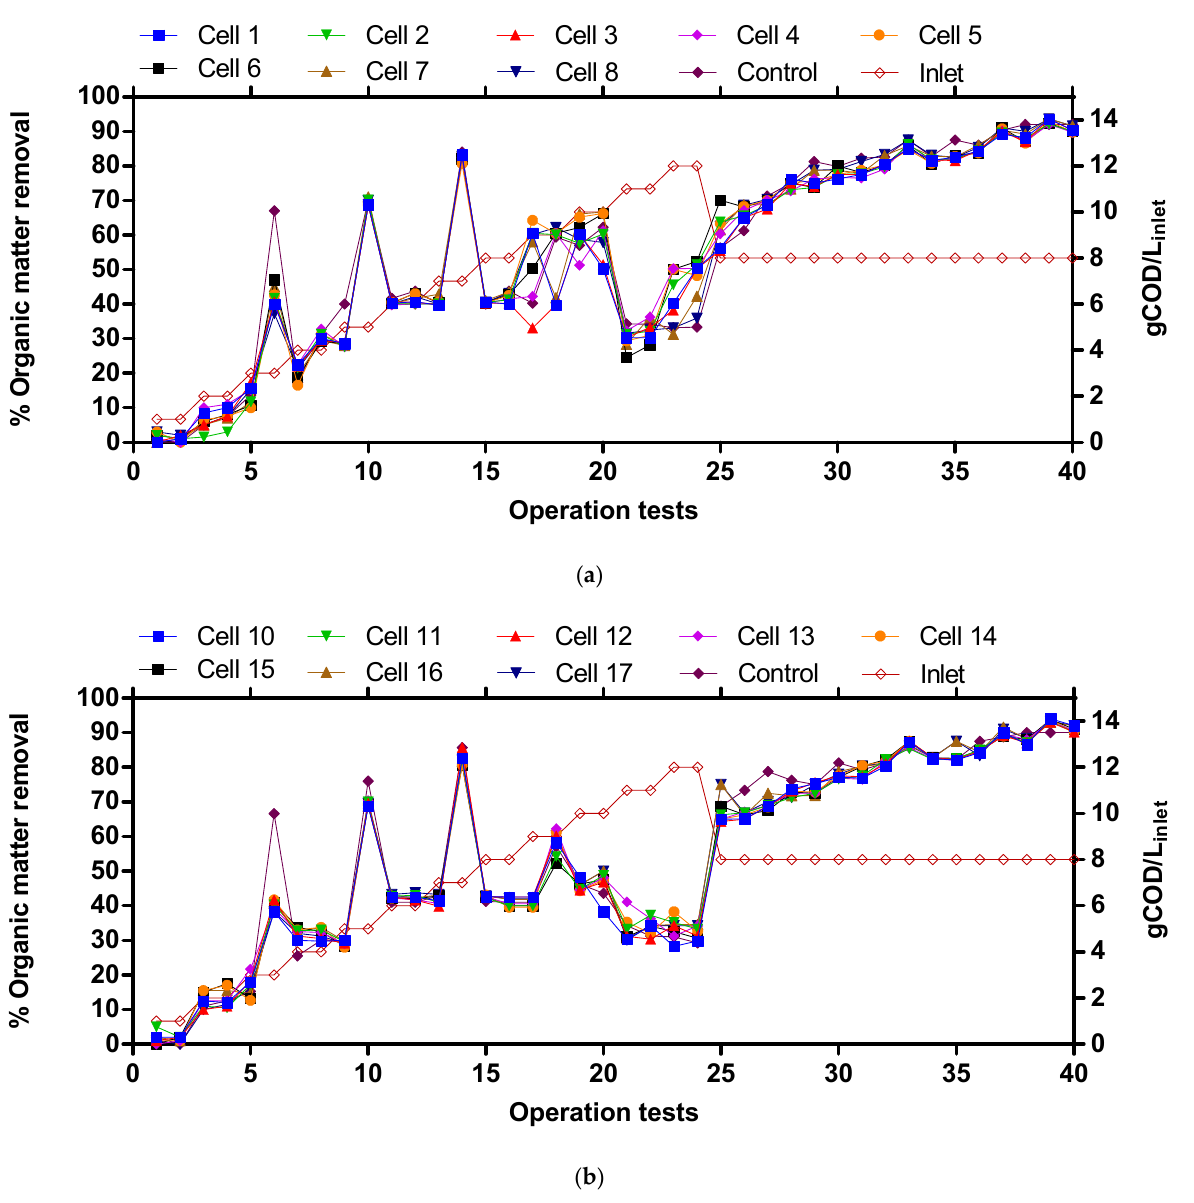
Figure 5. Average COD removal percentages by CW test: ( a ) RGV; ( b ) RGV + PE support. Trials 6, 10, and 14 presented considerable alterations, i.e., doubling or tripling of the removal percentage (60–85%), but this was due to the rain that occurred during the experiment. The rain filled the cells and diluted the input concentration, and this decreased the output concentration and caused an excessive amount of removal. This anomaly is justified, and it presented a slight decrease in the removal percentages of later tests. It can be inferred that the similarity between the yields of each cell was due to the filter material and its porosity, retaining the largest amount of suspended material and contributing to the fixation of matter for degradation by plant activity as shown in Figure 5a and as men- tioned by Tejeda et al. (2017) [47]. In spite of this, the cells with a mixture of beds (see Figure 5b) created spaces without porous material, which resulted in a decrease in the contact surface area and, hence, impaired the retention of suspended material. Even so, the amount of material that was removed was not reduced significantly due to the action